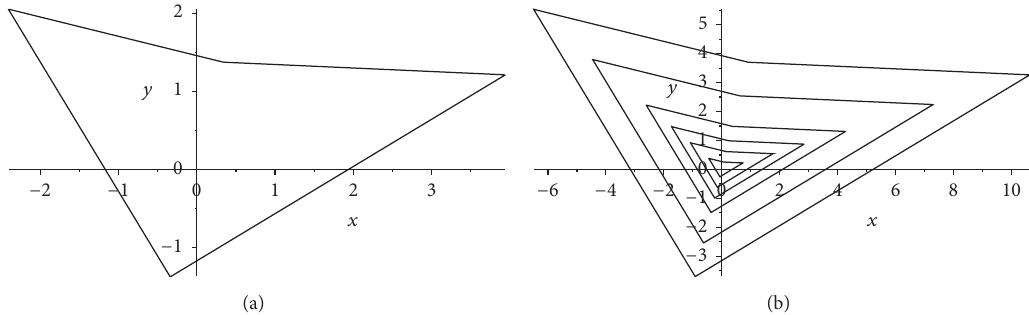
Figure 13: Orthogonal transformed contour defining tetragon P 𝑂𝑇 (a) and density level sets of the density of 𝑌 (b) in Example